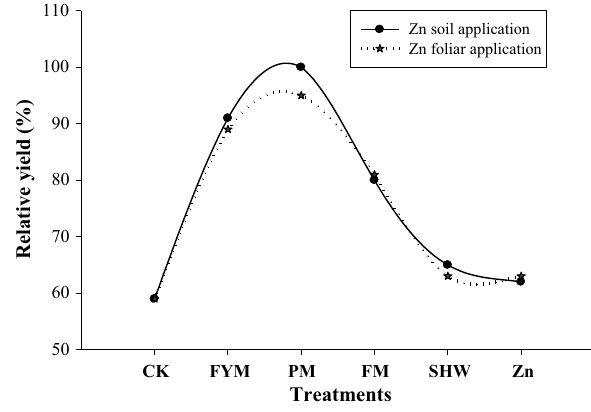
Fig. 3 Effect of organic manures and Zn fertilization on relative yield (%) of maize